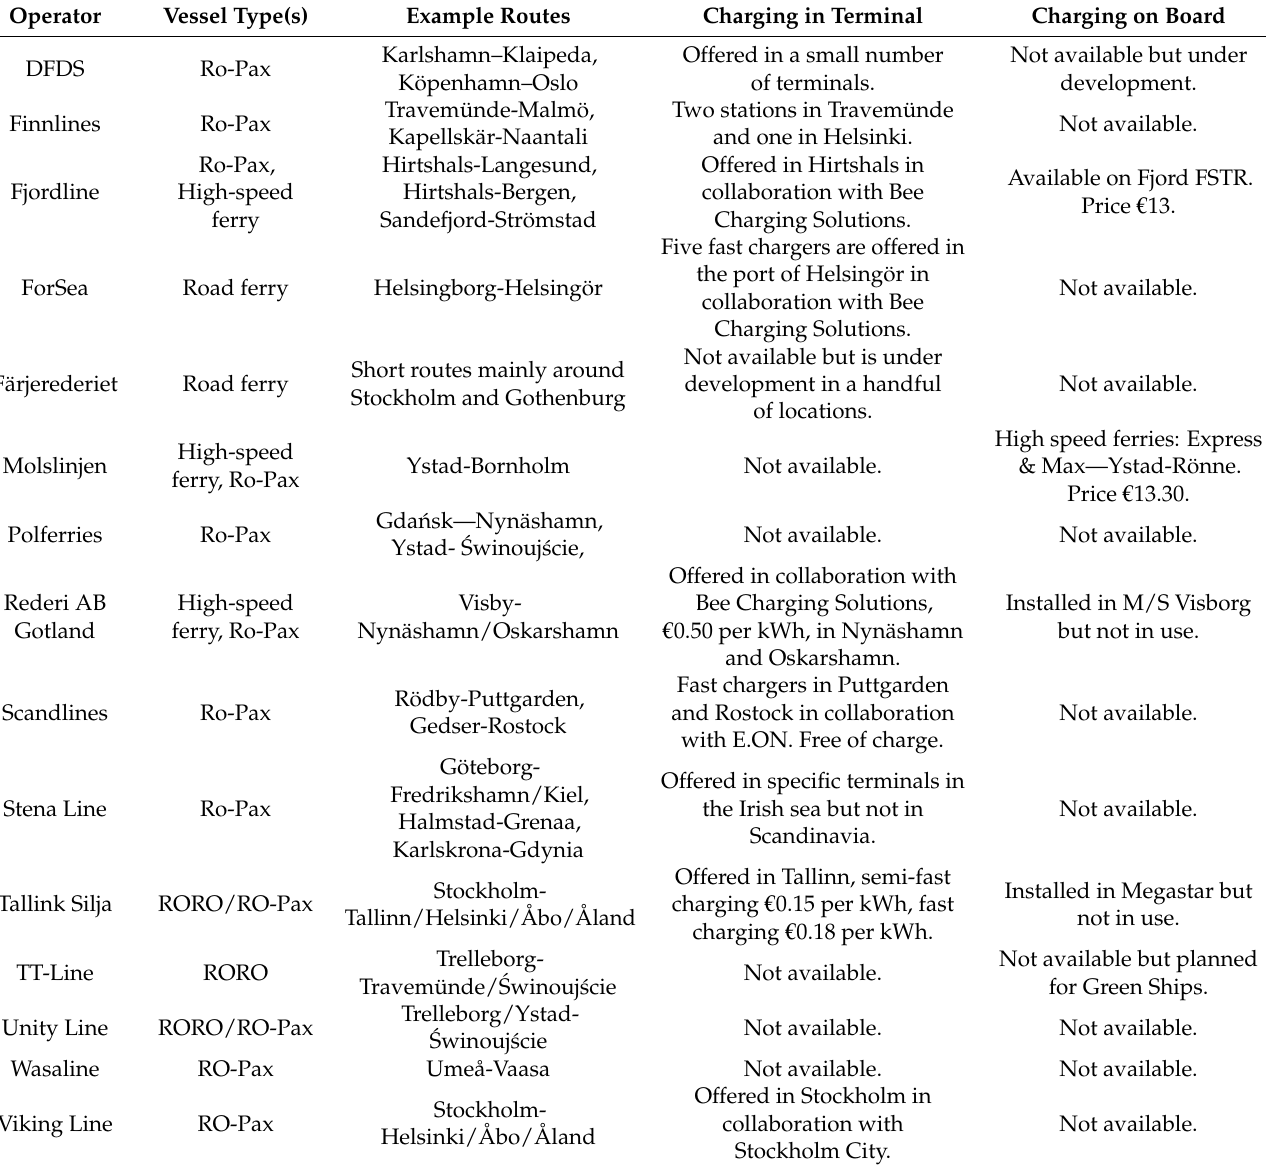
Table 3. Ferry operators’ charging